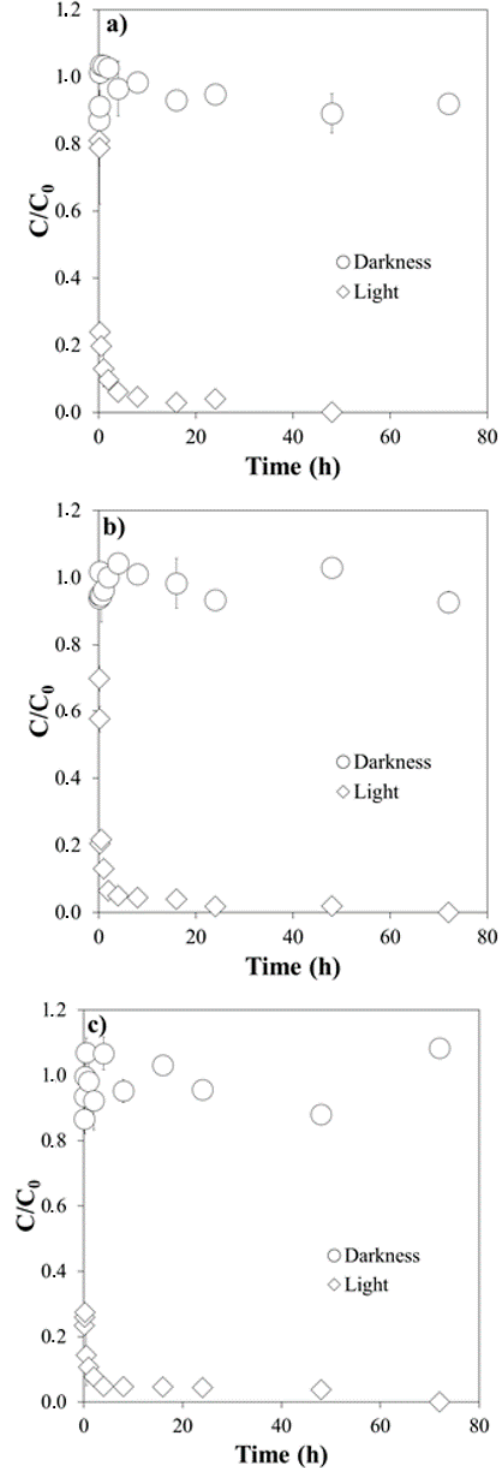
Figure 1. Degradation of Ciprofloxacin under simulated light and in the dark: ( a ) at pH 4.0; ( b ) at pH 5.5; ( c ) at pH 7.0. C/C 0 is the fraction of the initial concentration ( C 0 ) that remains in the suspension after a given time t. Cla degradation under simulated light was slower and decreased with increasing pH values. After 1 h of exposure, it reached 30% at pH 4.0, 27% at pH 5.5, and 17% at pH 7.0 (Figure 2).